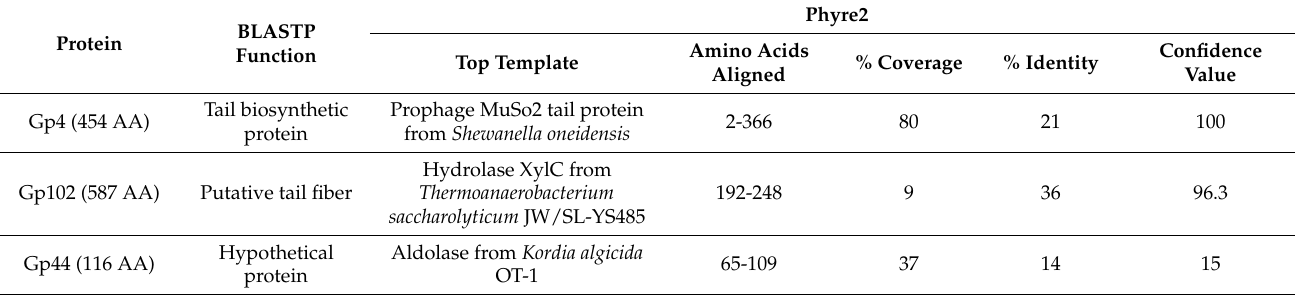
Table 3. RBP candidate protein